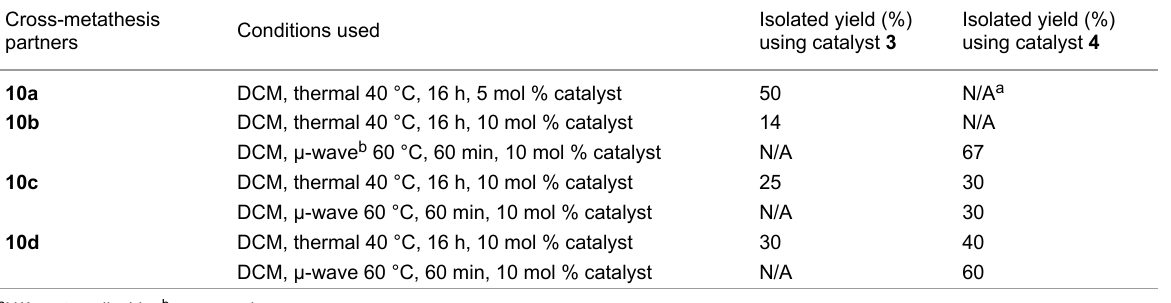
Table 1: Optimization of the cross-metathesis reaction between 9 and various alkenes. Cross-metathesis